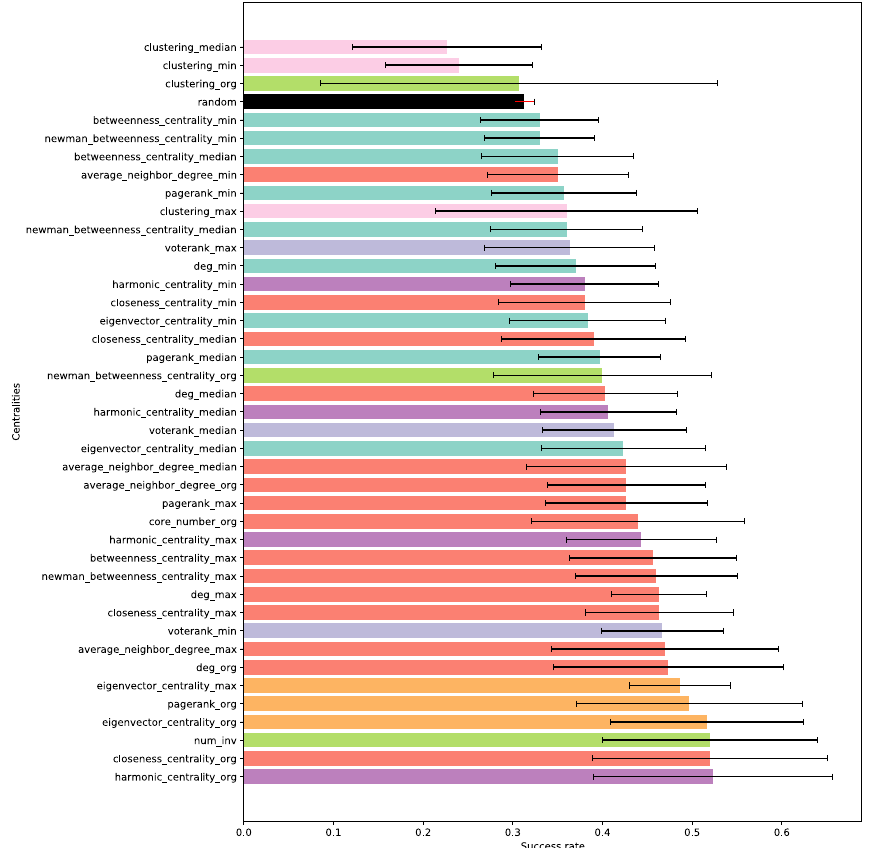
Fig. 2 Success rate for different centrality measures adopting the methodology proposed by Bonaventura et al. (2020). Bars represent mean success rates over 11 years (from 2000 to 2010), and are color-coded according to the partition of centrality measures obtained from the dendrogram in Fig. 3. Black lines mark ± 1 standard deviation intervals about the